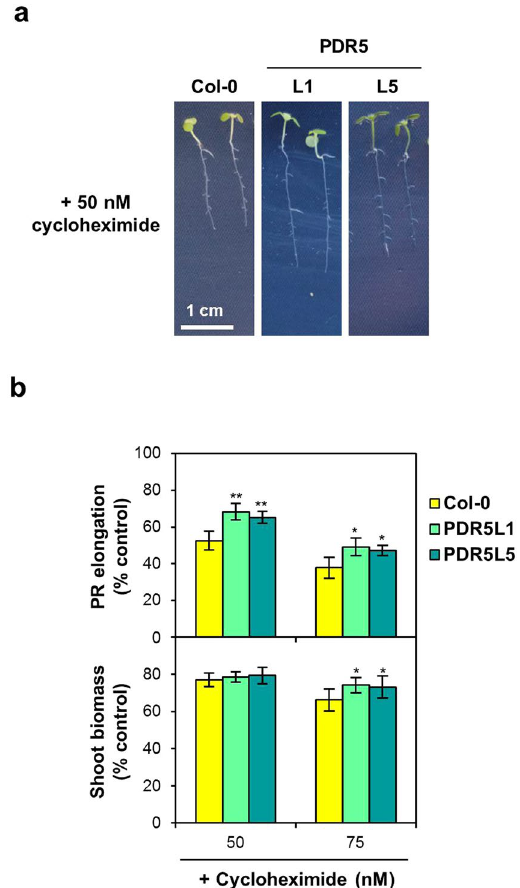
Figure 5. Effects of a cycloheximide challenge on transgenic Arabidopsis lines expressing the yeast Pdr5p transporter. ( a ) Representative images of 7-d old seedlings of the wild type (Col-0) and PDR5 (PDR5L1, L5) transgenic lines grown on medium containing cycloheximide. Plant growth under control conditions is shown in Fig. 1 and Table 1. ( b ) Effect of cycloheximide toxicity on PR elongation (upper panel) and shoot biomass (lower panel) of seedlings of the wild type (Col-0) and PDR5 (PDR5L1, L5) transgenic lines. Values represent means ± SD ( n = 8), with similar results being obtained in three independent experiments performed with different seed batches. Asterisks denote statistically significant differences between ScPDR5 -expressing lines and the wild type ( * P < 0.05, ** P < 0.01; Student’s t